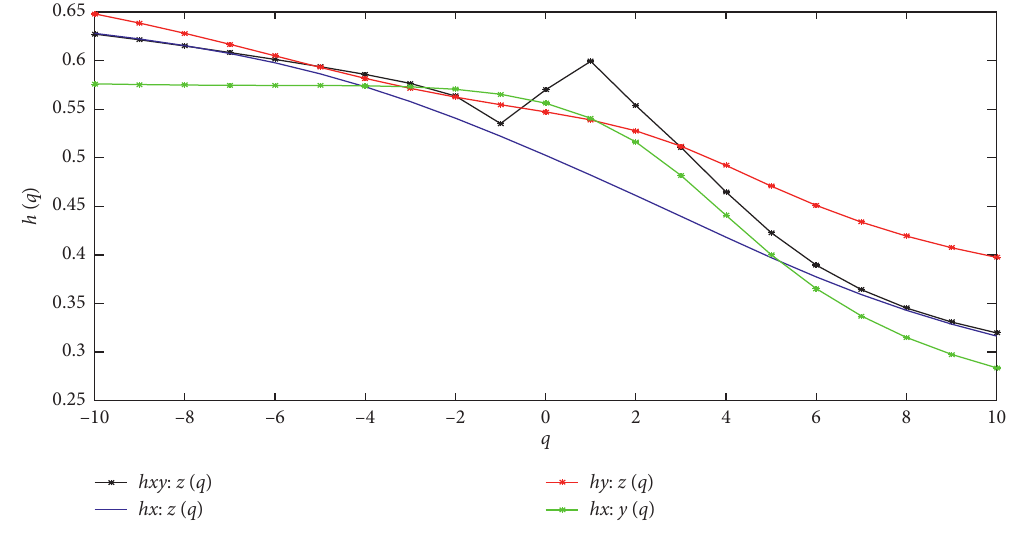
Figure 4: Generalized Hurst index. Table 2: Generalized Hurst index among various